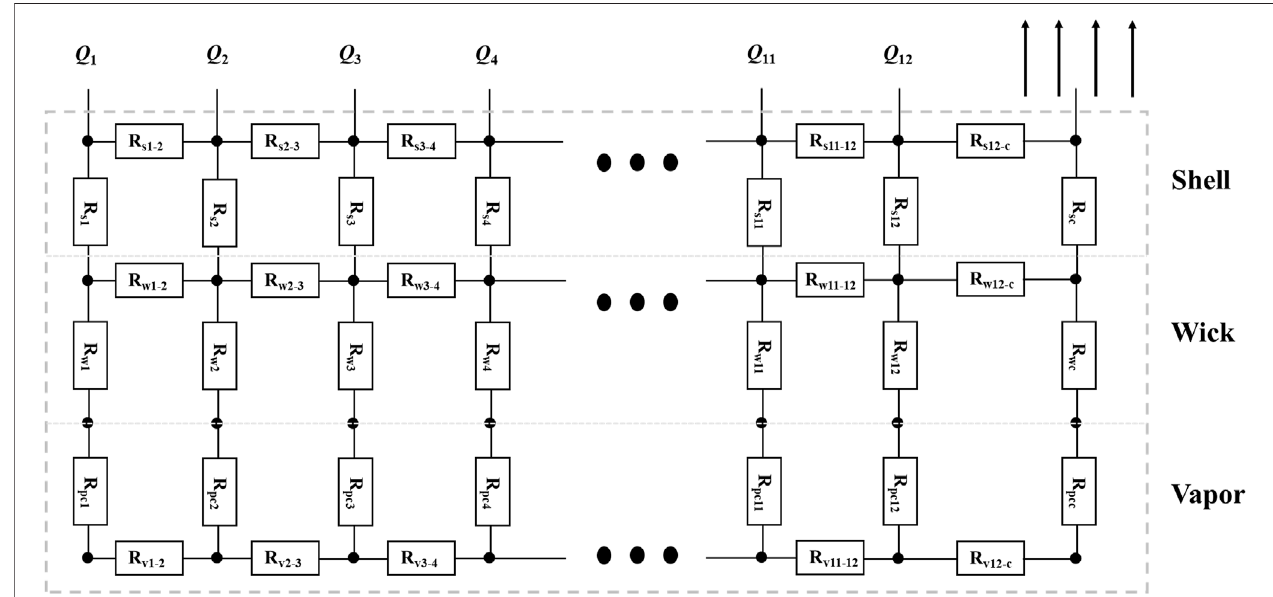
FIGURE 2 | Network scheme for a multi-heat-source